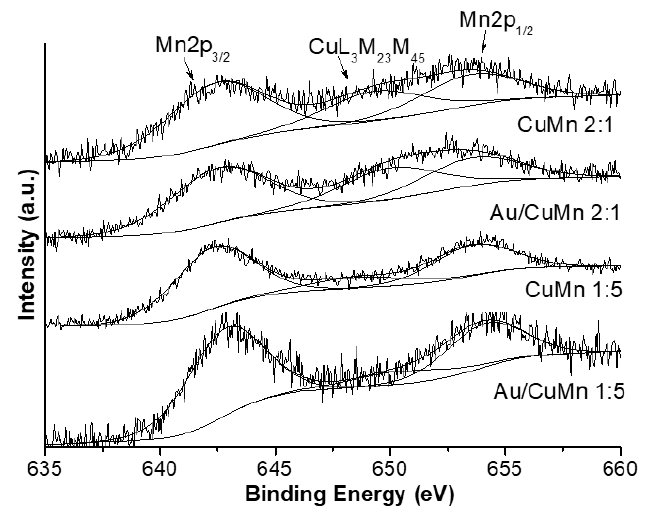
Figure 9. The Mn2p XP spectra of alumina-supported CuMn mixed oxides and gold-containing catalysts.